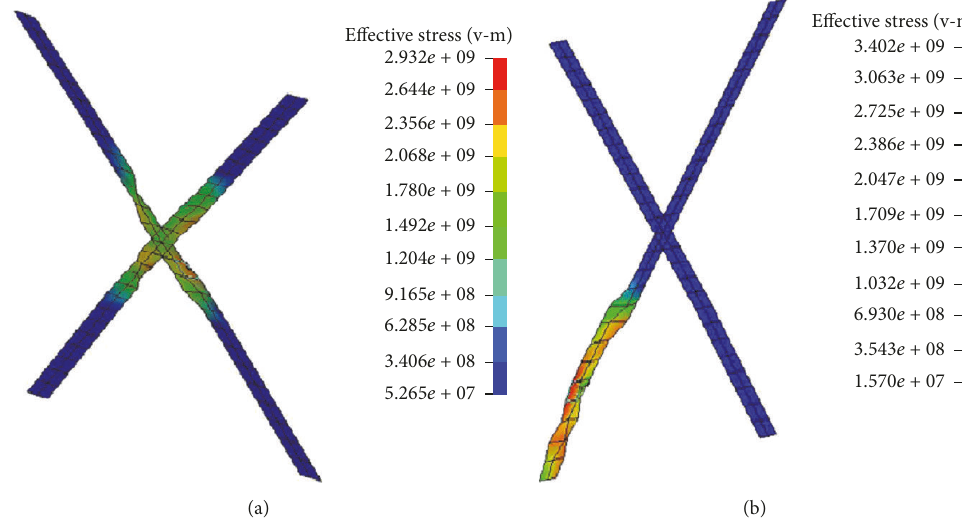
Figure 24: Stress distribution of FRP: (a) model 10, 𝑇 = 130 ms, and (b) model 11, 𝑇 = 150 ms.